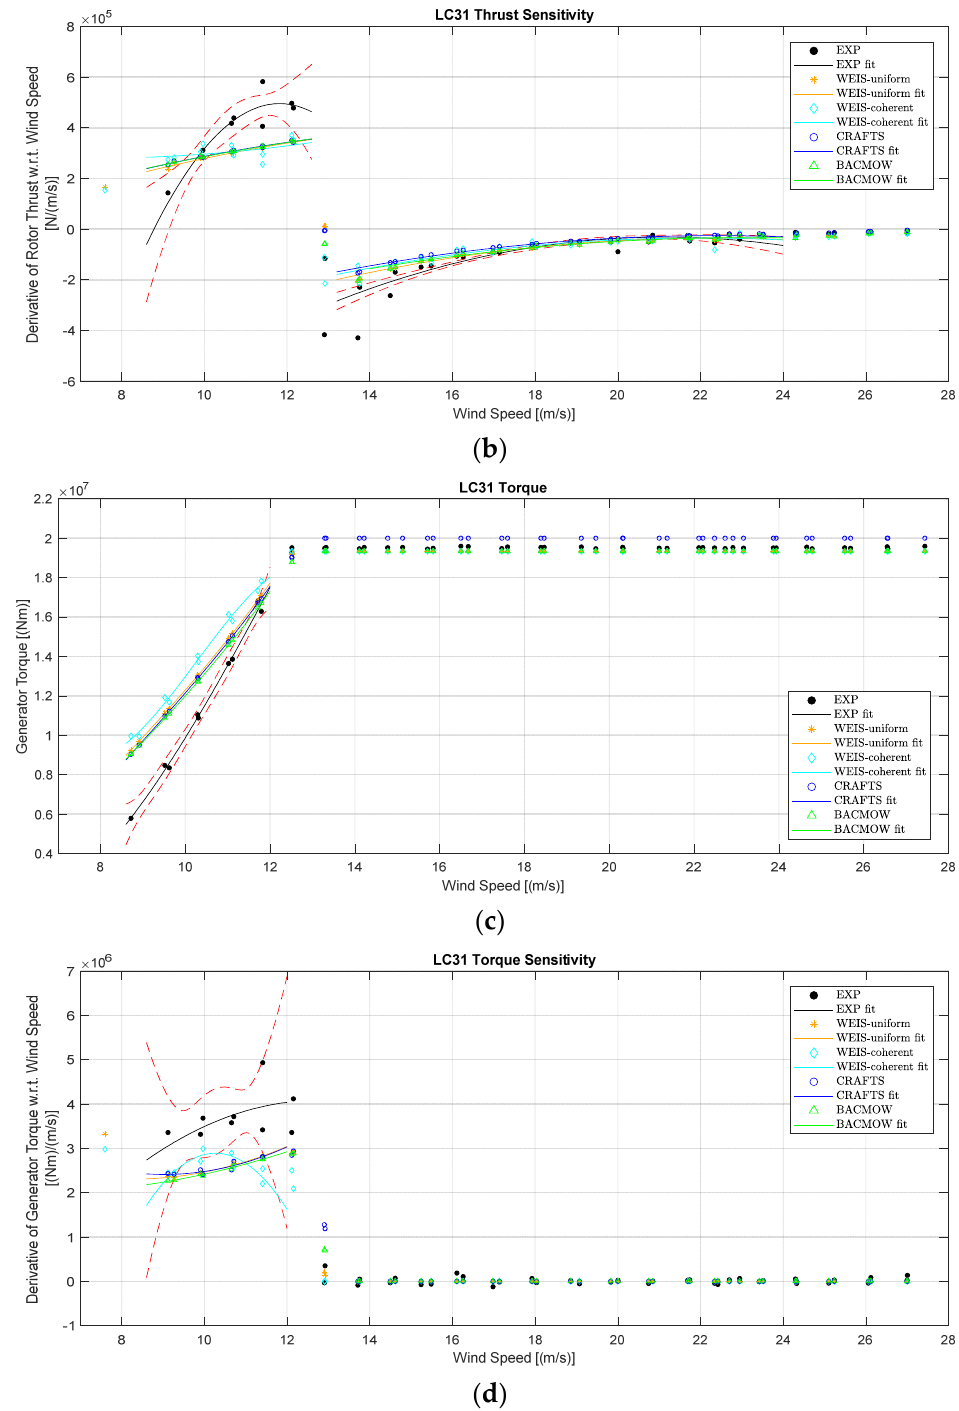
Figure 10. LC 3.1 thrust, torque, and their sensitivities with respect to wind speed: ( a ) thrust; ( b ) thrust sensitivity; ( c ) torque; ( d ) torque sensitivity. The red dashed lines show the uncertainty in the experimental data only.